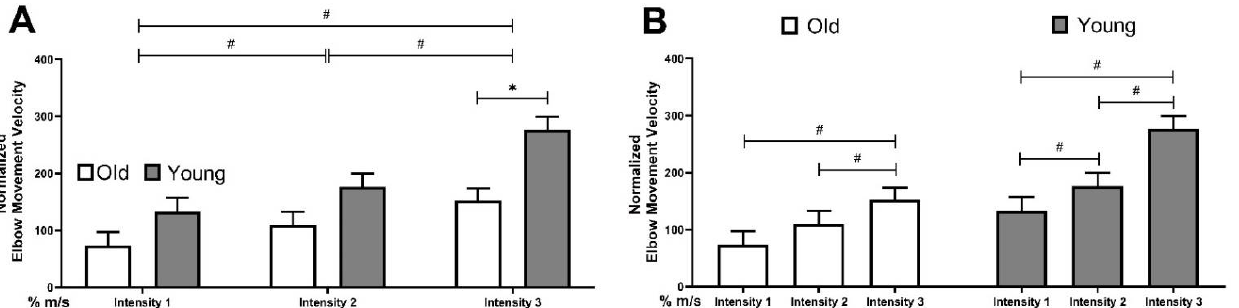
Figure 4. Maximal arm elevation velocity from perturbation onset to compensatory step touch down. # represents a difference between intensity levels, p < 0.05. * represents a difference between age groups, p < 0.05. Error bars display standard error. ( A ) Difference between two age groups at each perturbation intensity, ( B ) Difference between levels of perturbation intensity in each age group.